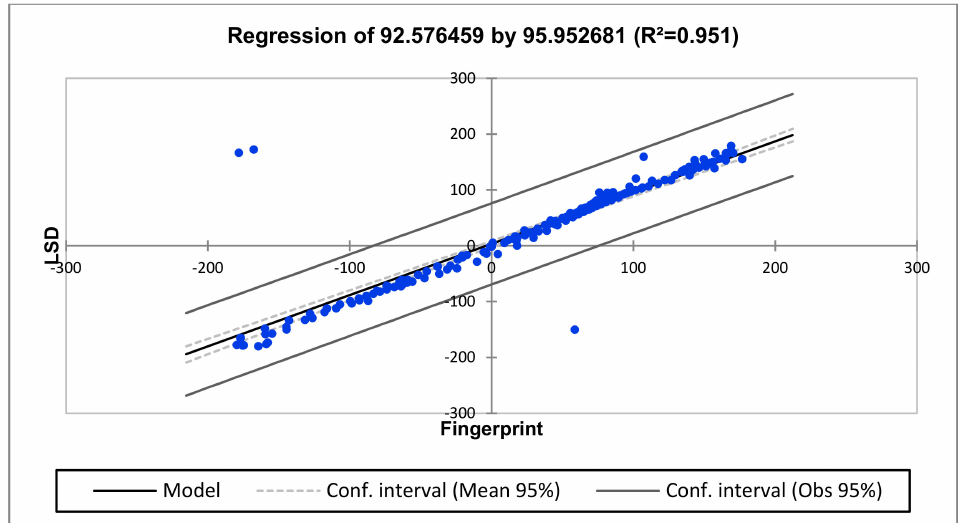
Figure 16. Regression of Phase C, tap position 1 (higher-frequency